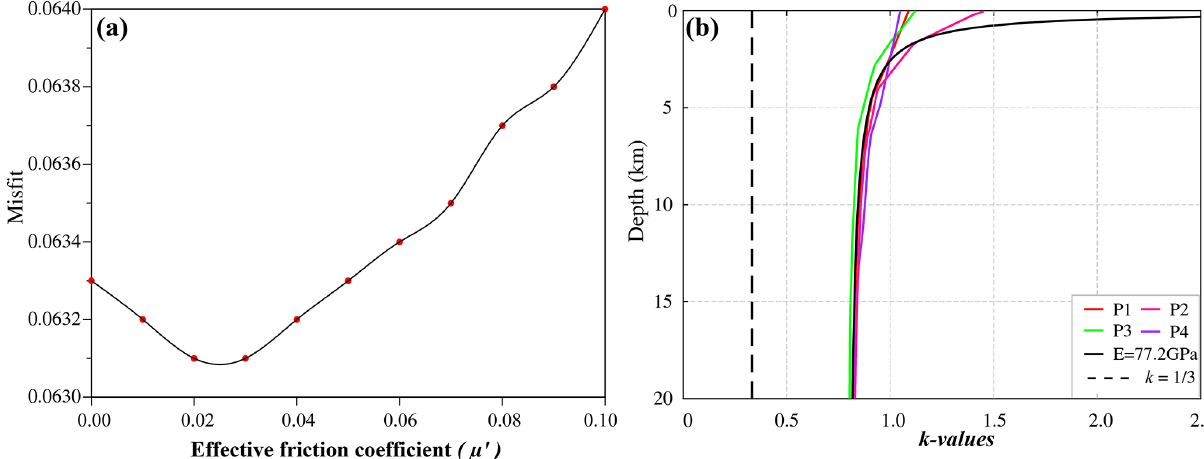
Figure 3. (a) Velocity misfit of the crustal velocity between the modeled results and GPS measurements as a function of the effective friction coefficient. The optimal friction coefficient was determined to be 0.02. (b) Depth profiles of the initial k values at four test sites indicated in Fig. 1. The solid black line shows the stress state based on Eq. (3), which was used as a reference stress state. For comparison, the low k value based on the uniaxial strain state is also shown (dashed black line).